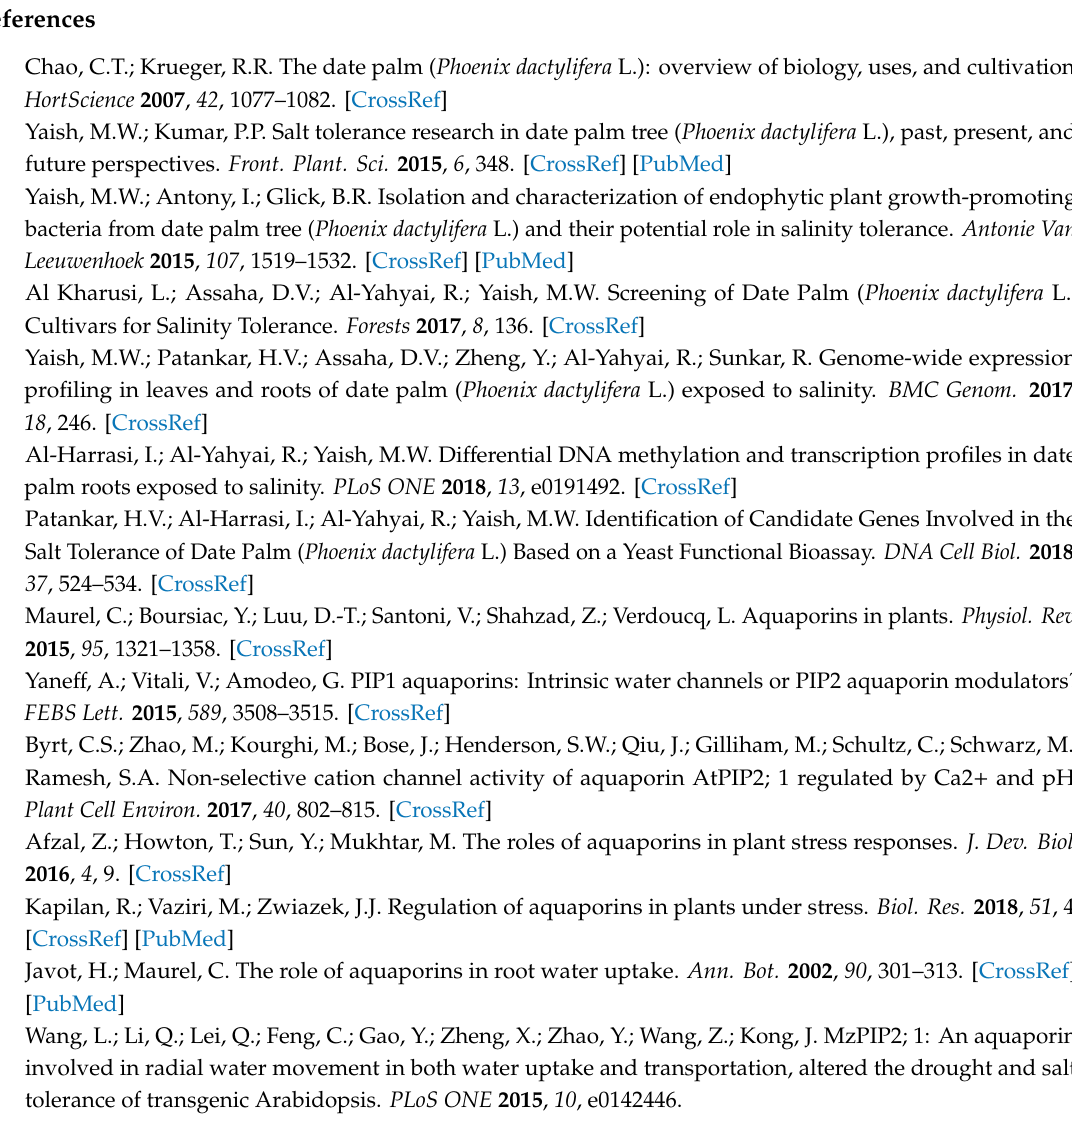
Figure S1a: The immunoblot analysis of PdPIP1;2 protein expression in leaf and root tissues under drought and salinity conditions, Figure S1b: The figure shows the normalized protein accumulation of the probable multimers of the PIP1 in leaf (A) and root (B) tissue detected on the immunoblot as seen in supplementary Figure S1A, Figure S2: Genotyping of transgenic Arabidopsis plants used to confirm the presence of the PdPIP1;2 gene, using 35S forward and OSC terminator reverse primers in the PCR, Figure S3: The total root length (A) and the total root surface area (B) measured using WinRhizo root scanning system, Figure S4: The mean moisture percentage, electrical conductivity (EC) and temperature of the soil measured on the 14th day of the stress treatment represented as a bar